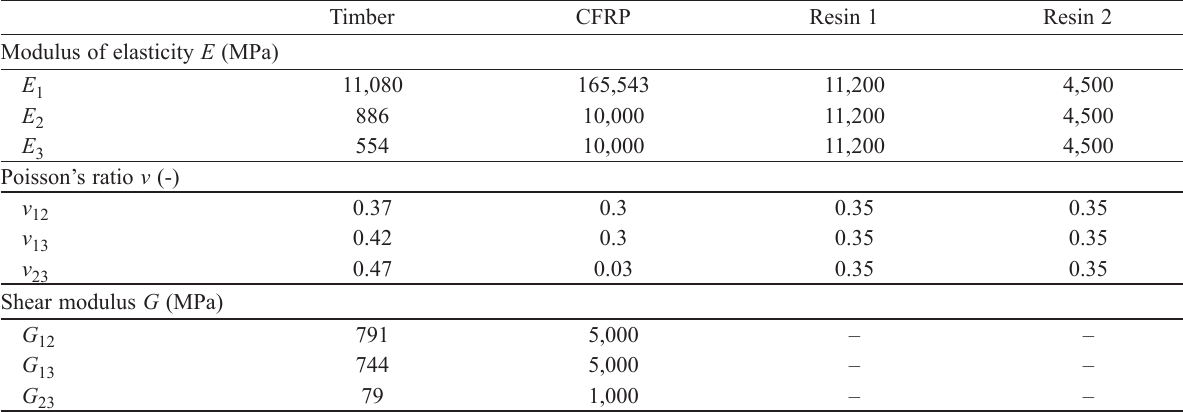
Table 6. Material parameters of timber, CFRP plate and epoxy adhesives used in numerical modelling